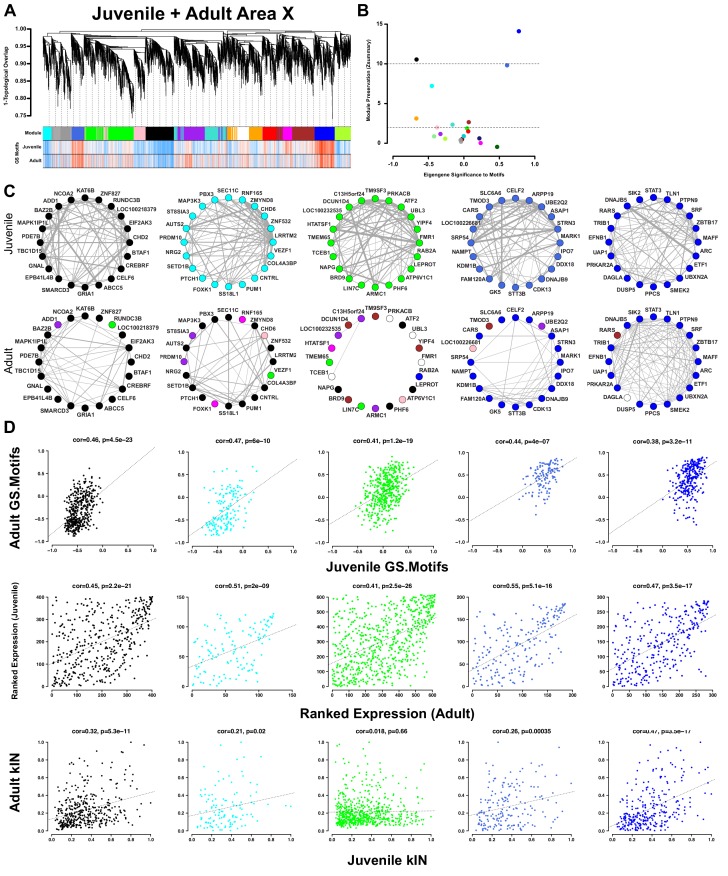
Area X song production but not learning-related modules are preserved into adulthood.(A) Dendrogram (top) displays the topological overlap in juvenile Area X between genes common to both juvenile and adult Area X networks. The module assignments and the gene significances to motifs in juveniles and adults are presented below. Module colors are consistent with those presented in Figure 3. (B) Module preservation (Zsummary) for all modules that were present in both juvenile and adult Area X displayed as a function of ME correlation to motifs. Lower and upper dashed horizontal lines indicate thresholds for low and high preservation, respectively. (C) Circle plots display the adjacencies between the 20 most well-connected genes in the juvenile Area X black, cyan, green, royalblue, and blue modules. The adjacency between genes are indicated by edge thickness. Genes grouped together in the black, cyan, royalblue, and blue song modules in Area X have numerous and strong connections that are mostly maintained in adulthood. The densely interconnected green learning-related module genes found in juveniles do not maintain these relationships in adulthood. (D) Strong positive correlations between gene significance to motifs exist for all modules (top row). Ranked expression values for the genes in each module also show positive correlation (middle row). Intramodular connectivity is more positively correlated between ages for the black, cyan, royalblue, and blue song production modules than for the green learning-related module (bottom row).10.7554/eLife.30649.028Figure 5—source data 1.An R workspace containing the expression data and networks used to generate (A).